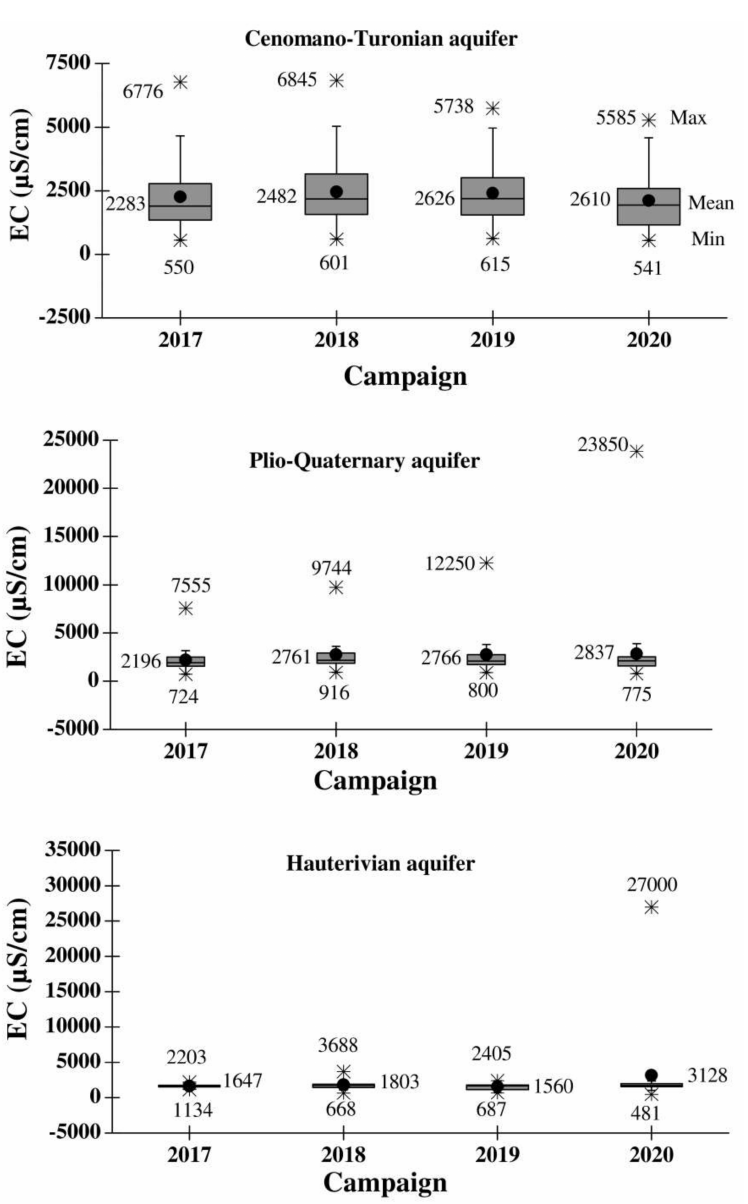
Figure 9. Electrical conductivity statistics for the 2017, 2018, 2019, and 2020 campaigns for the Cenomano-Turonian, Plio-Quaternary, and Hauterivien